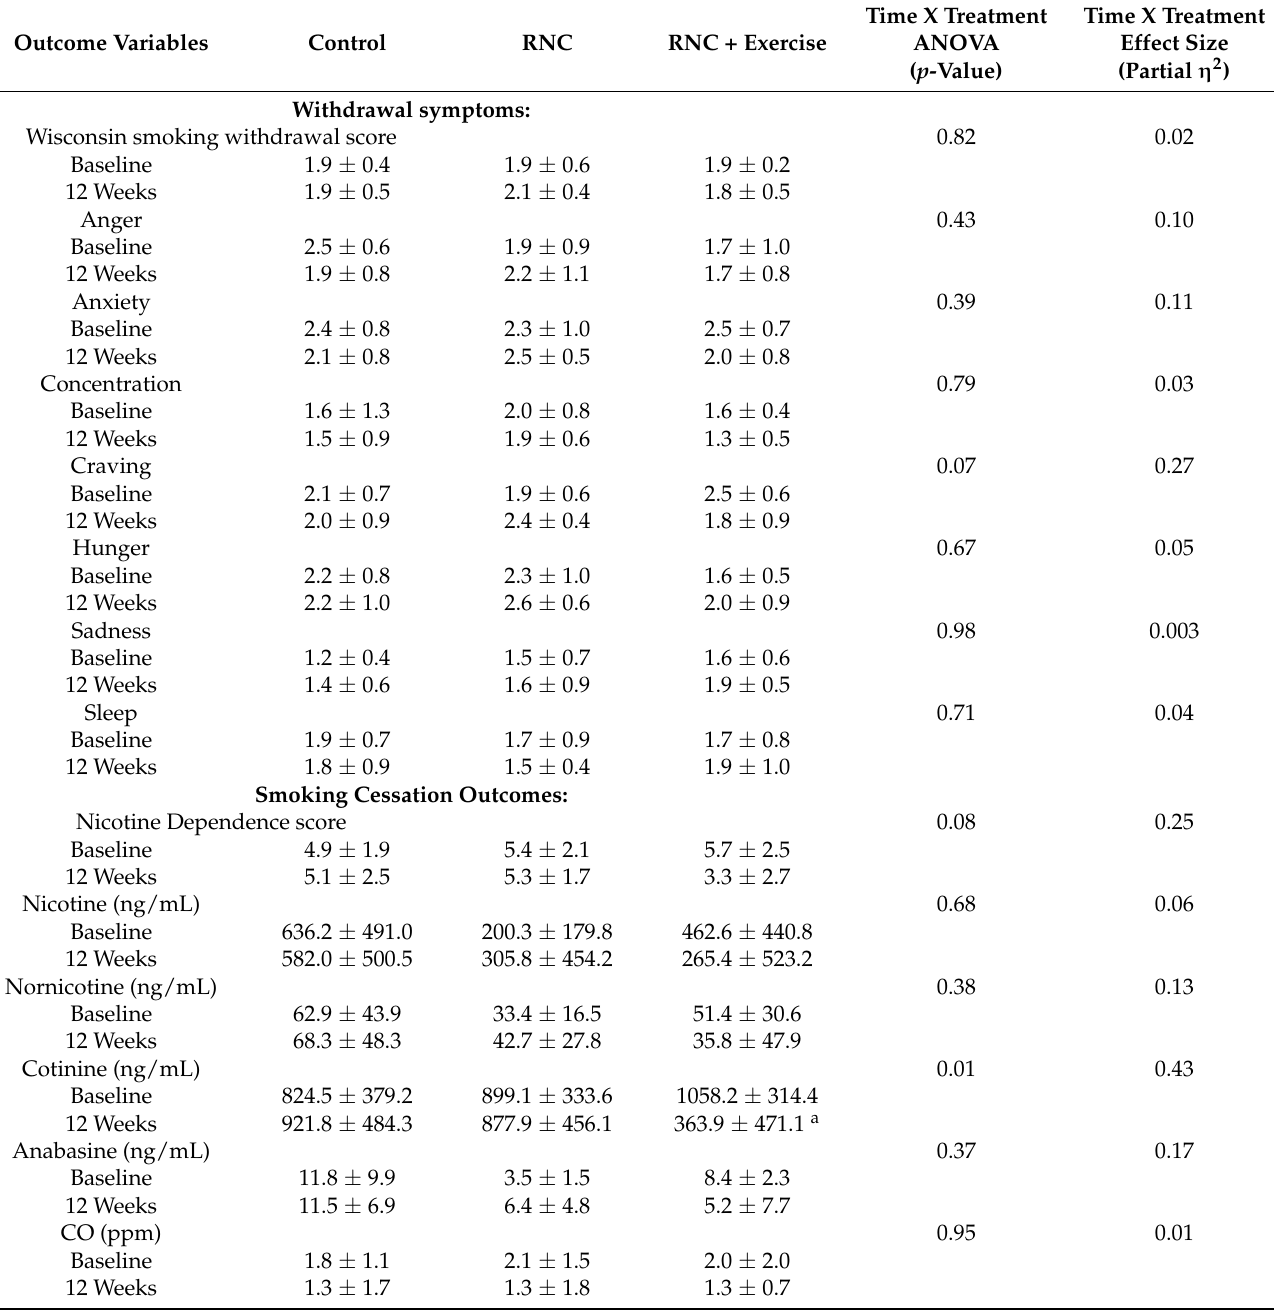
Table 2. Effect of RNC with and without Exercise on smoking withdrawal